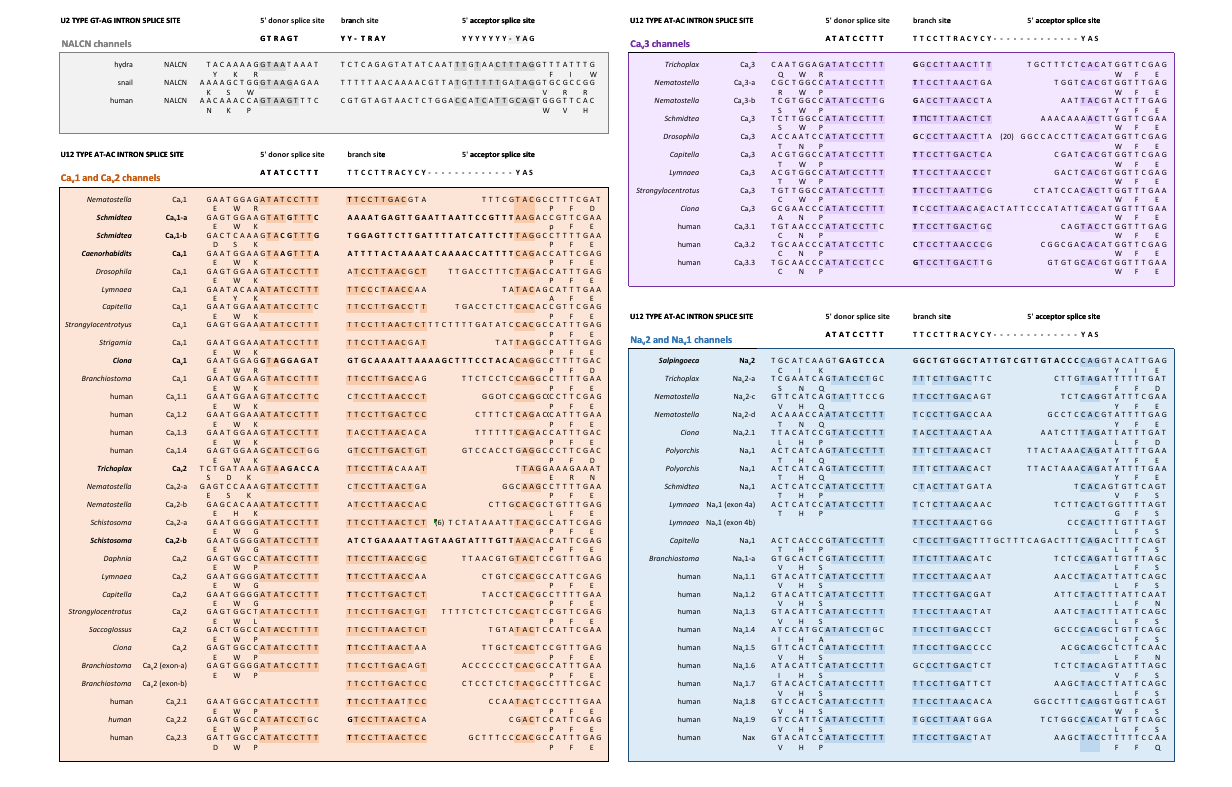
FIGURE 6 | Conservation of a very rare U12 type intron splice site in Domain 1, segment 1 of Na v 2, Na v 1, Ca v 1, Ca v 2, and Ca v 3 channels, but not NALCN channels. Exceptionally rare U12-type splice site represent just 700–800 putative genes (or ∼ 4%) of total genes in mammalian genomes. Consensus 5 (cid:48) donor splice site (ATATCCTTT), branch site (TTCCTTRACYCY) and 5 (cid:48) acceptor splice site (YAS) recognition sequences of minor U12-type spliceosome varies from conventional major U2-type spliceosome recognition sequences with consensus 5 (cid:48) donor splice site (GTRAGT), branch site (YY-TRAY) and 5 (cid:48) acceptor splice